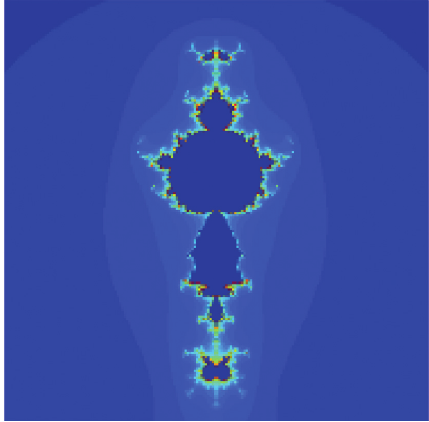
Figure 8: The general Mandelbrot set P � √ ( 0 , − 1/ ) . 3